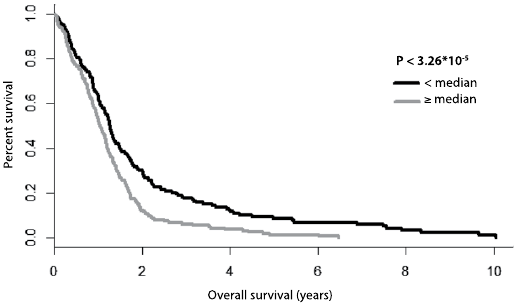
Figure 4. Kaplan-Meier survival curves estimating OS in GBM patients from the TCGA data set according to the 7-miRNA based Risk